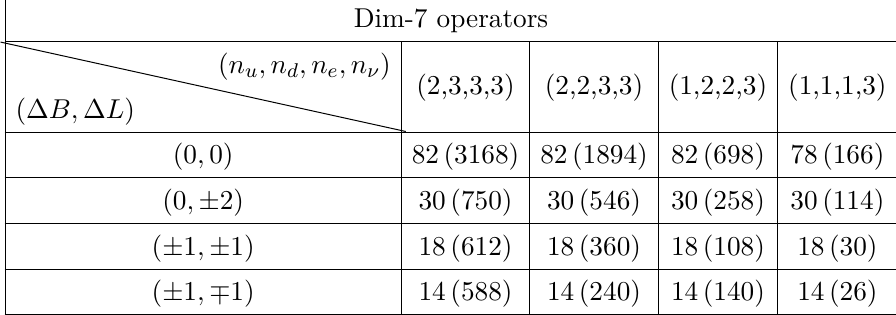
, n , n and n represent active number u d e ν = 2 and u = 3 , 2 , 1 corresponds active e